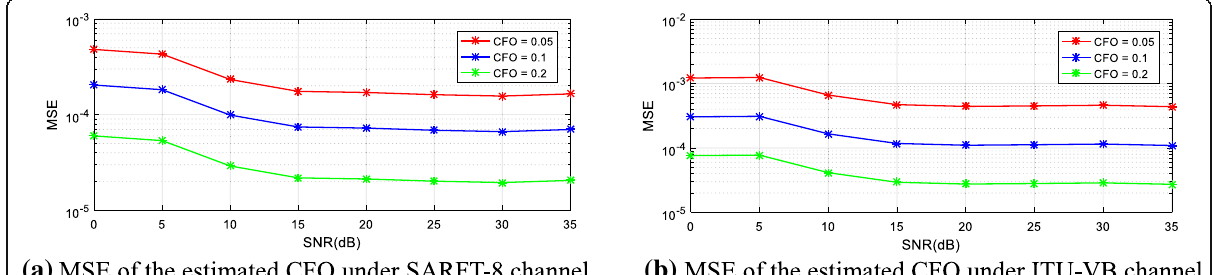
Fig. 5 The MSE performance of the proposed CFO compensation scheme in 16 × 16 MIMO-OFDM system with f max = 20 HZ